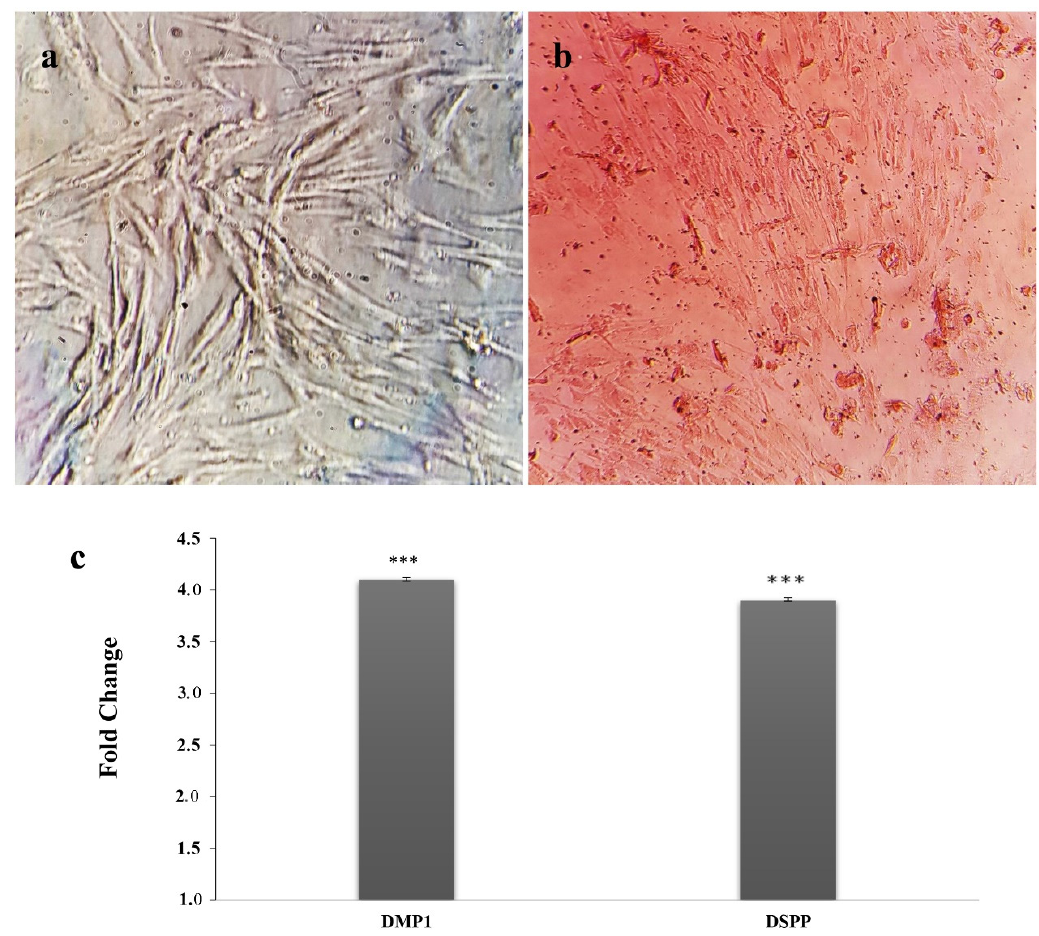
Figure 2. ( a ) The control sample. ( b ) Examining the differentiation of C-EnSCs into odontoblast, 21 days after differentiation. C-EnSCs that have differentiated into odontoblast cells and calcium storage deposits are marked in red. ( c ) Evaluation of expression analysis of DMP1 and DSPP genes after 21 differentiations in an odontogenic environment at mRNA level using qRT-PCR. The experiment was repeated at least three times, and the normalizing gene was Actin-B. *** shows a significant difference with the control group at the level of p < 0.001.